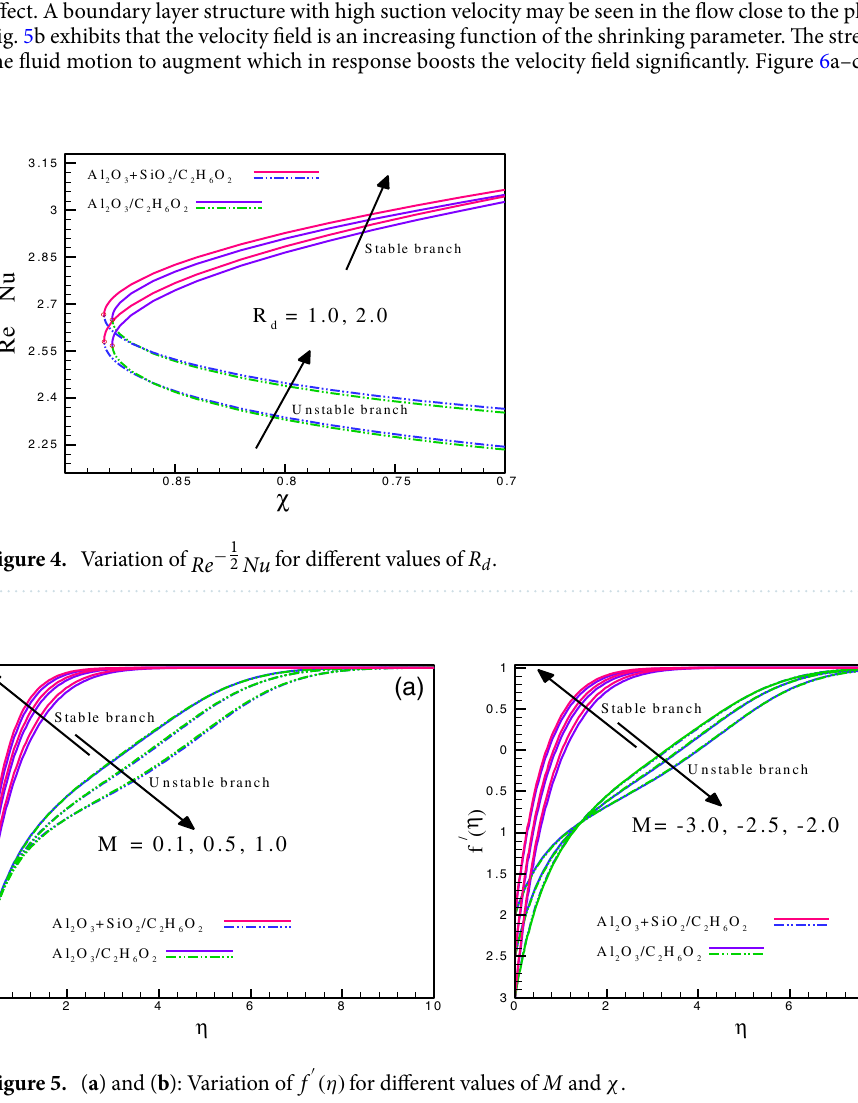
Figure 5. ( a ) and ( b ): Variation of f